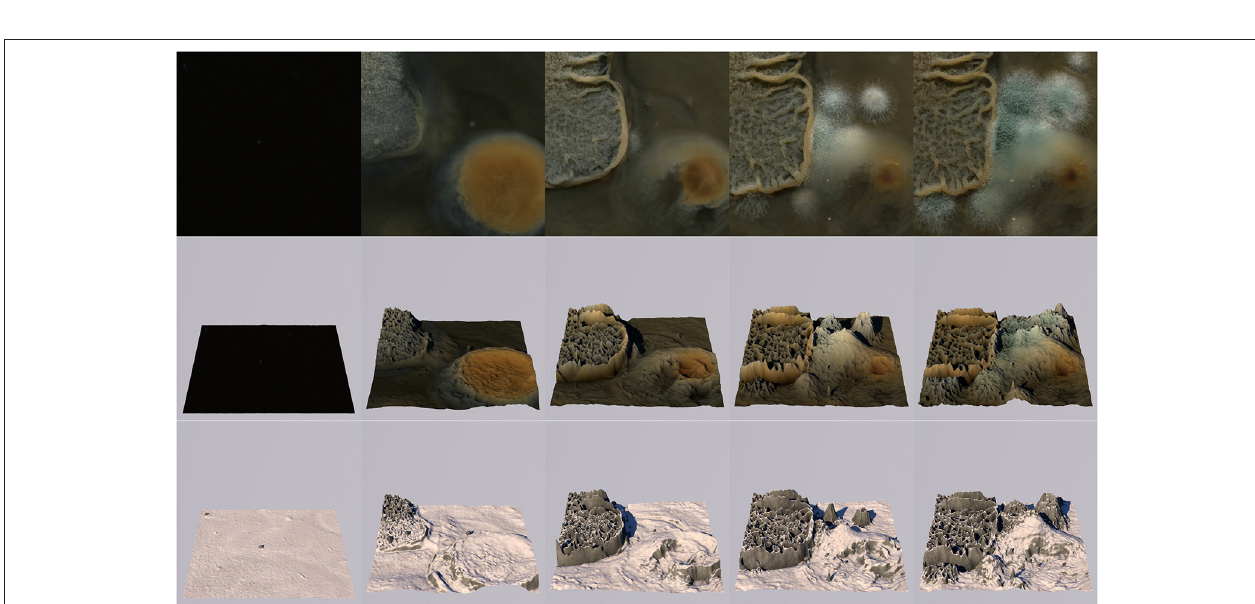
FIGURE 8 | Five stages of the growth process with roughly 2-day intervals, from left to right. The top row shows the microbial scans (same region as in Figures 5 – 7 ); the middle row shows the generated terrain colored by the images’ color data; the bottom row shows the terrain with accumulated virtual snow.